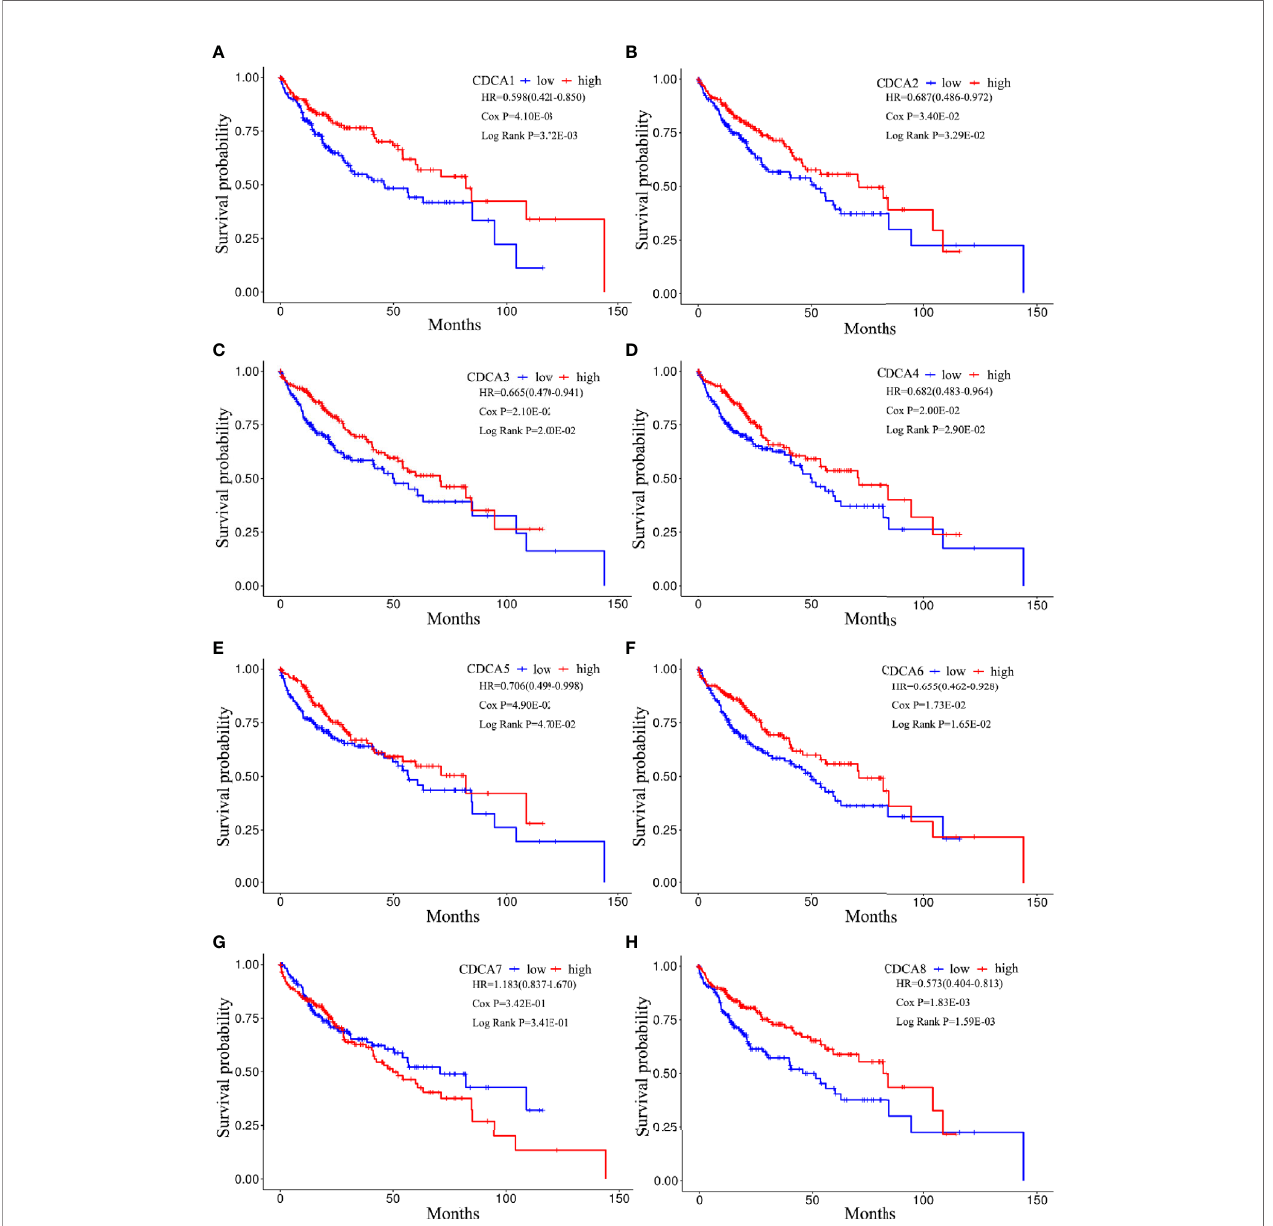
FIGURE 10 | Kaplan-Meier curves for CDCAs methylation groups. Survival analyses for (A) CDCA1, (B) CDCA2, (C) CDCA3, (D) CDCA4, (E) CDCA5, (F) CDCA6, (G) CDCA7, and (H) CDCA8. Patient samples are dichotomized based on the median methylation levels of each CDCAs. P-value refers to the cox and log-rank tests. HR shows the hazard ratio and 95% con fi dence